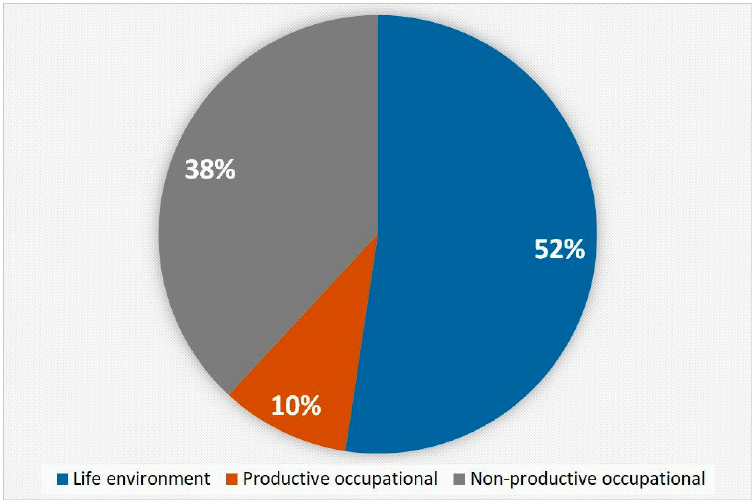
Figure 4. Synthesis of the environment typologies assessed in the reviewed studies.